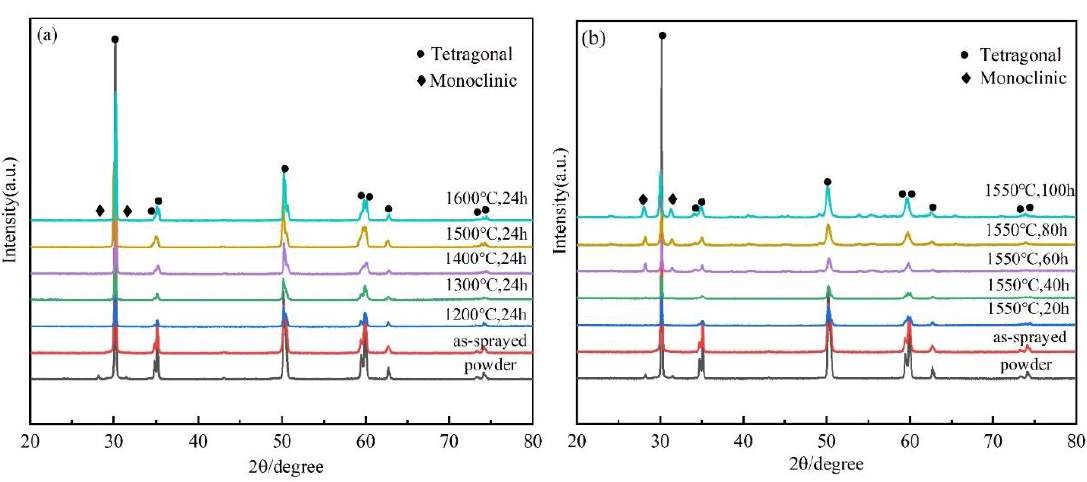
Figure 2. XRD patterns of the powder, as-sprayed coating and the coatings after thermal aging treatment: ( a ) top coatings after aging for 24 h at different temperatures ( b ) top coatings after aging at 1550 °C for different times. (Tetragonal is meant as a group of equilibirium tetragonal (t-YSZ), metastable tetragonal (t′-YSZ) and yttrium-rich tetragonal (t″-YSZ) phases).